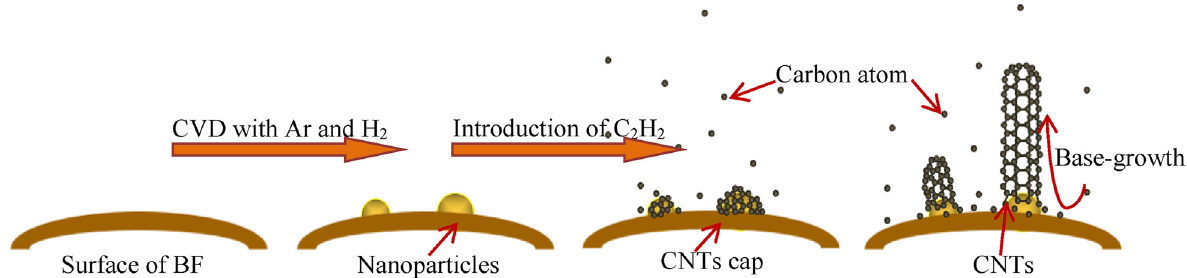
Figure 2: Schematic of CNTs growth on basalt fi bers surface [ 33 ]